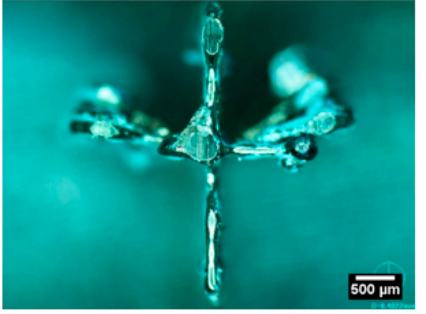
Figure 19. Optical microscope analysis of 0.10 mm and 0.15 mm thick crosses from selected participants. Each picture presents a short description below.